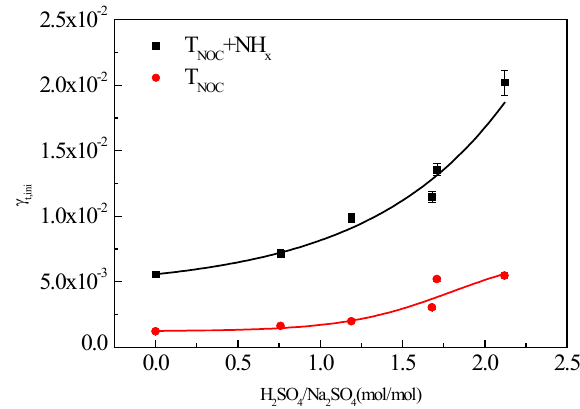
Figure 5. Relationship between the γ t , ini and particle-phase acidity when including (black) and excluding (red) NH x in the determina- tion of γ . The error bars are derived from the uncertainties of the uptake model parameters.